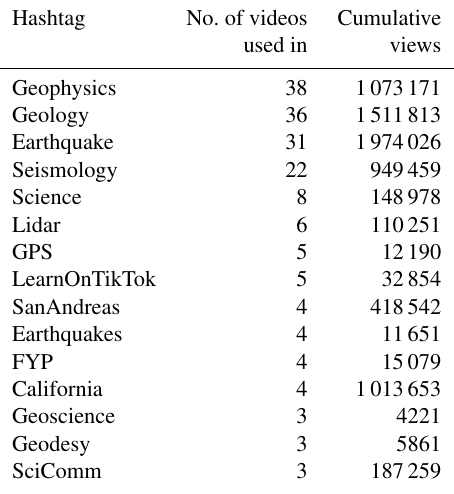
Table 4. Top 15 most commonly used hashtags on the Terra Explore videos, indicating the number of videos they were used on and the cumulative views associated with hashtag use. (FYP: For You